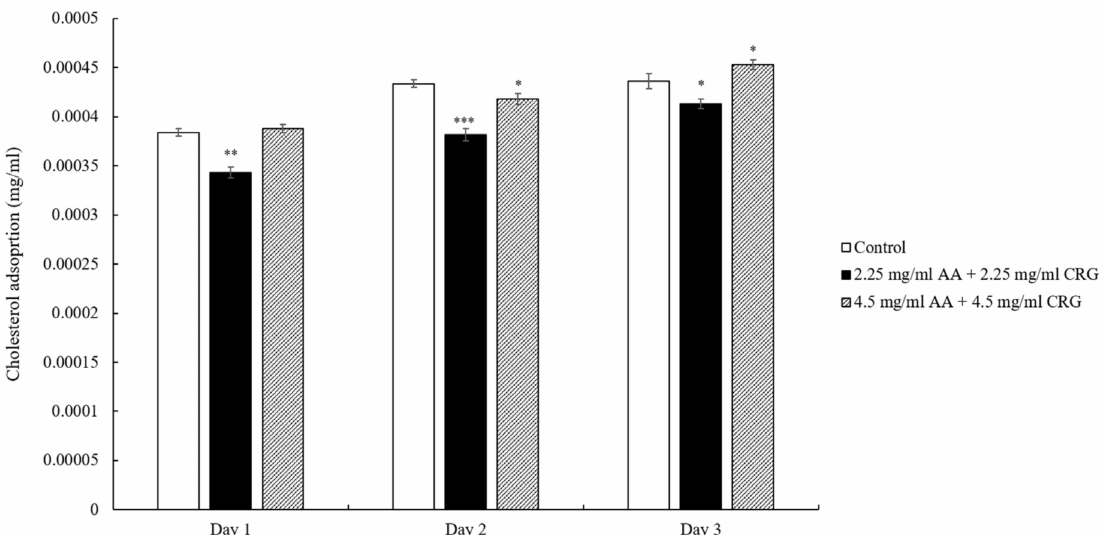
Figure 2. The concentration of cholesterol adsorption on the ortho-k lens when being immersed in artificial tear solution (control, white bars), 2.25 mg/mL (black bars) or 4.5 mg/mL (grey slashed bars) polysaccharides-containing artificial tear solution. * p < 0.05, ** p < 0.01, and *** p < 0.001 when comparing cholesterol adsorption amount in polysaccharides-containing artificial tear solution versus in control on the same day. Error bars represented standard